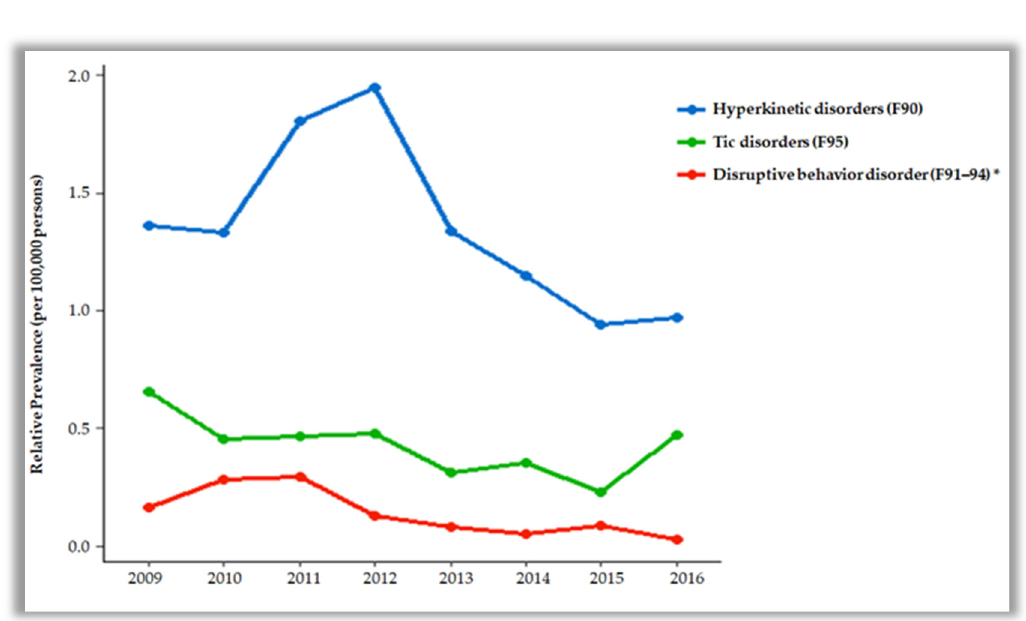
Figure 1. Distribution of mental disorders in male patients by year ( p value of slope, * <0.05). The total numbers of R and Z codes were 317 (males 62.8%) and 98 (males 68.4%),